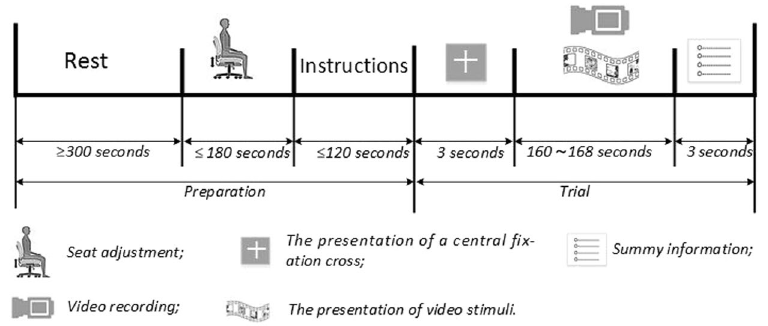
Figure 8. A schematic diagram of the experimental protocol